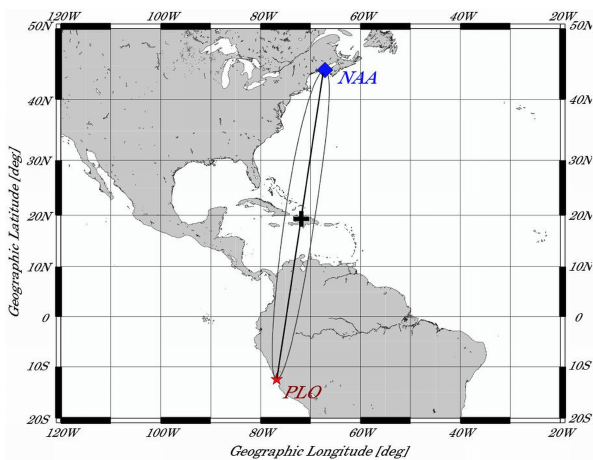
Fig. 1. Relative location of the VLF transmitter (NAA), a VLF receiving station in Peru (PLO) and the EQ epicentre (indicated by a cross). The great circle path and the fifth Fresnel zone are also